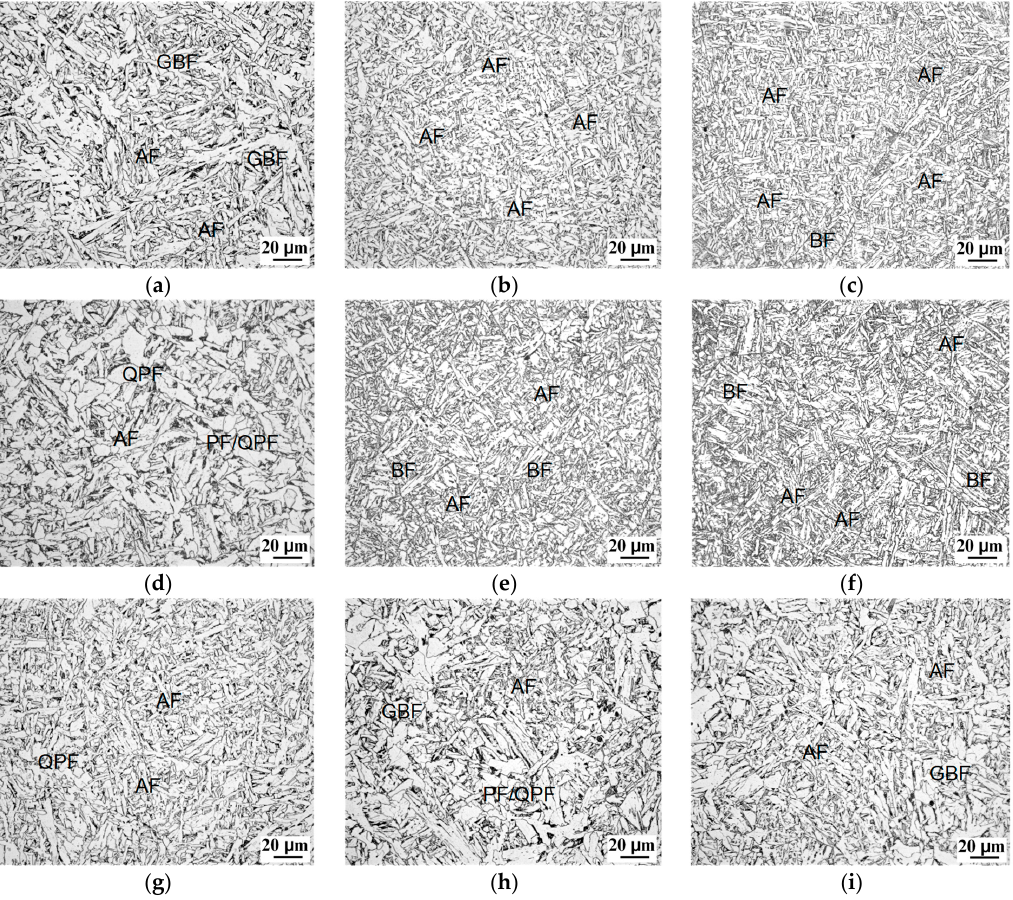
Figure 7. Microstructures of TC# steel formed at cooling rates of ( a, d, g – i ) 2 °C/s, ( b, e ) 5 °C/s, and ( c, f ) 15 °C/s under different deformation conditions: ( a – c ) No deformation; ( d – f ) 43%, 5 s − 1 ; (g) 15%, 5 s − 1 ; ( h ) 65%, 5 s − 1 ; ( i ) 43%, 3 s − 1 , at 1050 °C. Hot deformation exhibited greater influence on transformation for TC# steel in comparison to AC# steel. The effects of deformation on TC# steel microstructures consisted of the following three aspects. First, the temperature range of phase transformation was enlarged after applying deformation, as referred to in Figure 5c,d. More microstructural constituents would form at a certain cooling rate. Second, at lower cooling rates, grain boundary or intragranular polygonal ferrite (PF) grains increased. Quasi-polygonal ferrite (QPF) grains with irregular boundaries were also included, as demonstrated in Figure 7d. Third, at higher cooling rates, bainite packets growing from austenite grain boundaries increased significantly, as indicated in Figure 7e,f. These effects mainly resulted from the increase in recrystallized austenite grain boundaries, which acted as effective nucleating sites. Figure 7g–i shows the effects of deformation degree and strain rate. It was obviously found that a small reduction of 15% (Figure 7g) was quite favorable for AF formation compared to that of 43% (Figure 7d) and 65% (Figure 7h) under the same strain rate of 5 s − 1 and cooling rate of 2 °C/s. The AF structure morphology was even better developed than that without deformation (Figure 7a). A proper small deformation contributed to inhibiting WF formation through reducing the coarse austenite grain size and resulted in a full AF microstructure formation. However, an excessive large deformation would cause a remarkable increase in the grain boundary reaction product. In contrast,